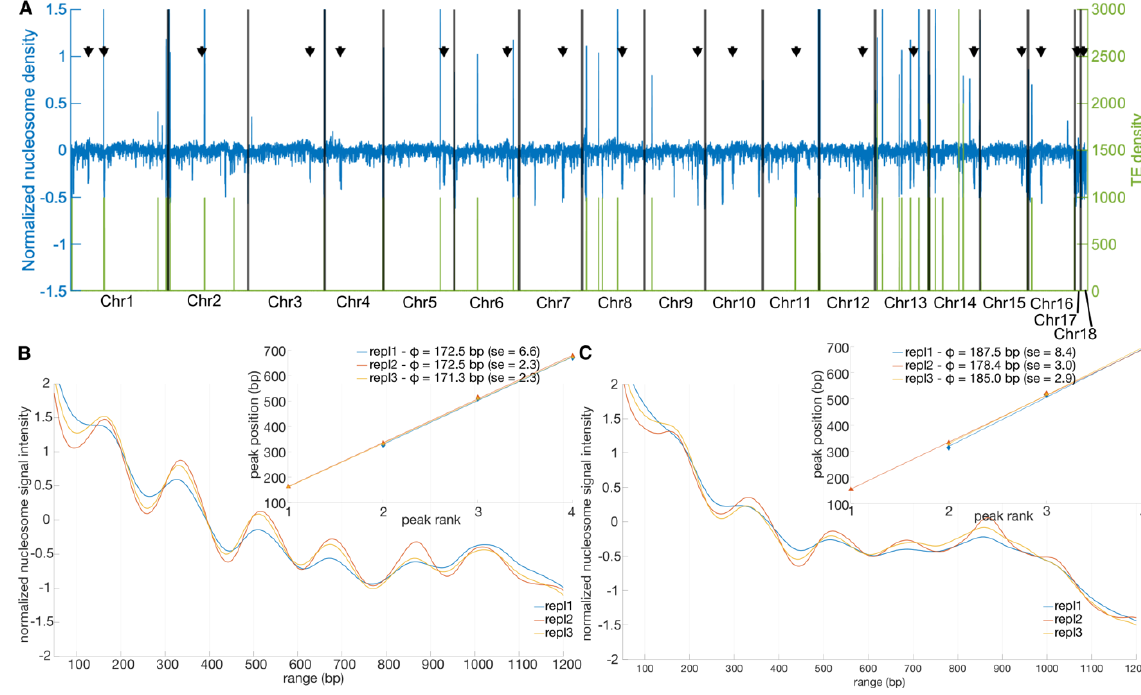
Figure 2: Nucleosome density profiles in Botrytis cinerea . A. Coverage density profiles were computed for non- overlapping 1 kb-long bins along the chromosomes of B. cinerea. In green are plotted BOTY transposable elements (TE) density profiles. In blue are plotted the z-scored average nucleosome density profile (see Supplementary Figure 2 for individual replicate plots). Black arrows indicate putative positions of centromeres (Van Kan et al. , 2017); B and C. Nucleosome phasing in BOTY TE (B) or TE other than BOTY TE (C). Main graphs display phase frequencies (y-axis) as a function of position (in base pair; x-axis). Graphs in inserts show peak positions (in base pairs; y-axis) as a function of peak order (x-axis); Phases +/- standard errors (se), R2 (coefficient of determination), and p-values (F-test) are determined after linear regression fitting to the first four successive peak positions (see Supplementary Table 3). Repl =